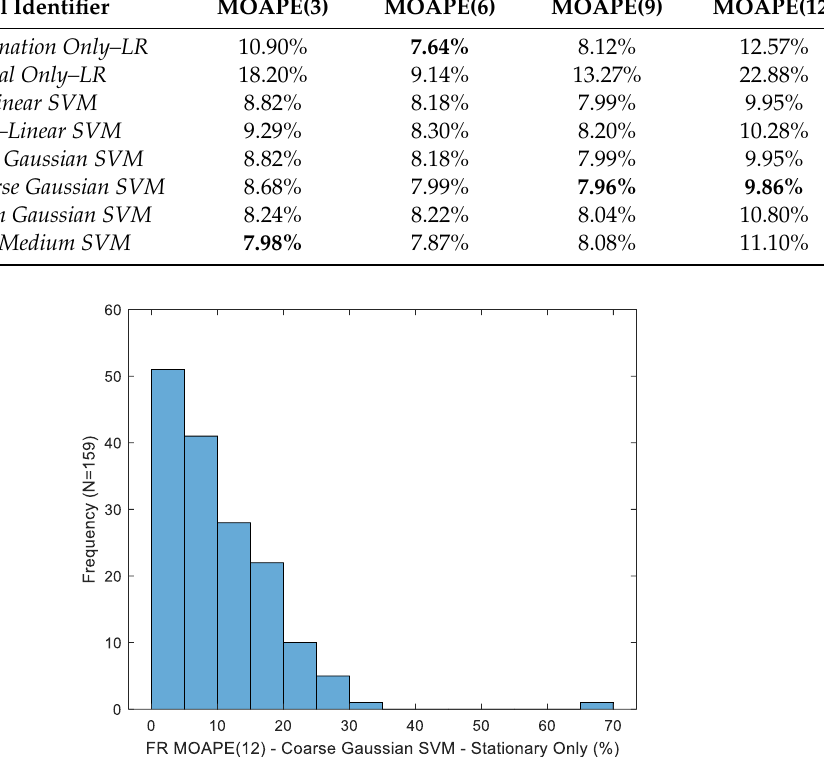
Figure 12. Distribution of the fill ratio mean overall absolute percentage error after 12 drinks for the best-case estimator.